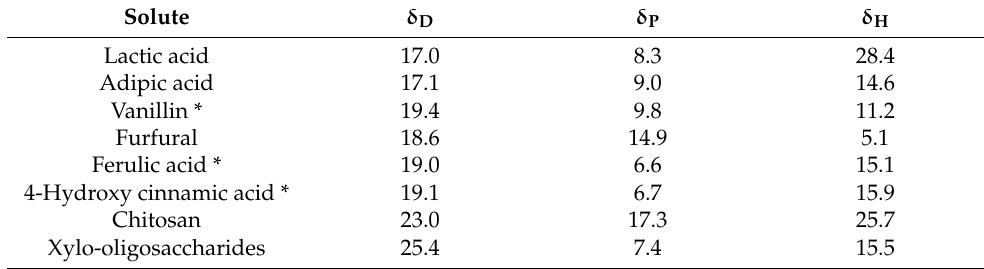
Table 11. HSP values of solutes